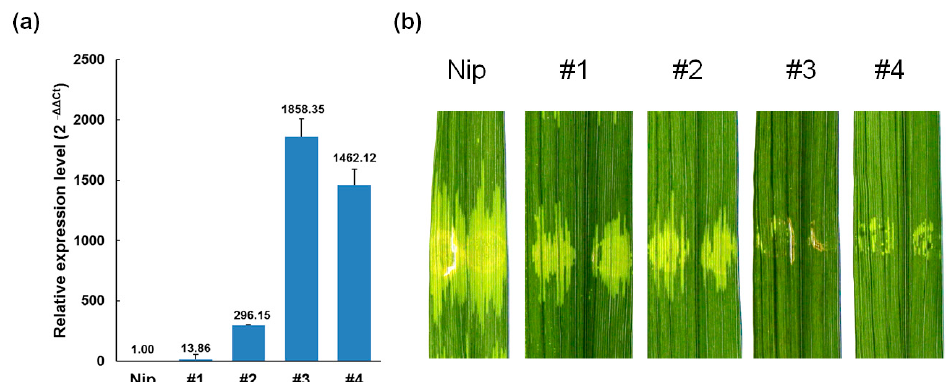
Figure 3. The basal levels of expression of Xa23p1.0 in transgenic rice plants. ( a ) The background expression of Xa23 in the T 2 plants of Xa23p1.0 transgenic rice. Relative expression levels were shown as a bar graph. ( b ) Disease reactions of Xa23p1.0 transgenic rice leaves to Xoc strain RS105, which was conducted by needleless syringe infiltration at OD600 = 1.0.